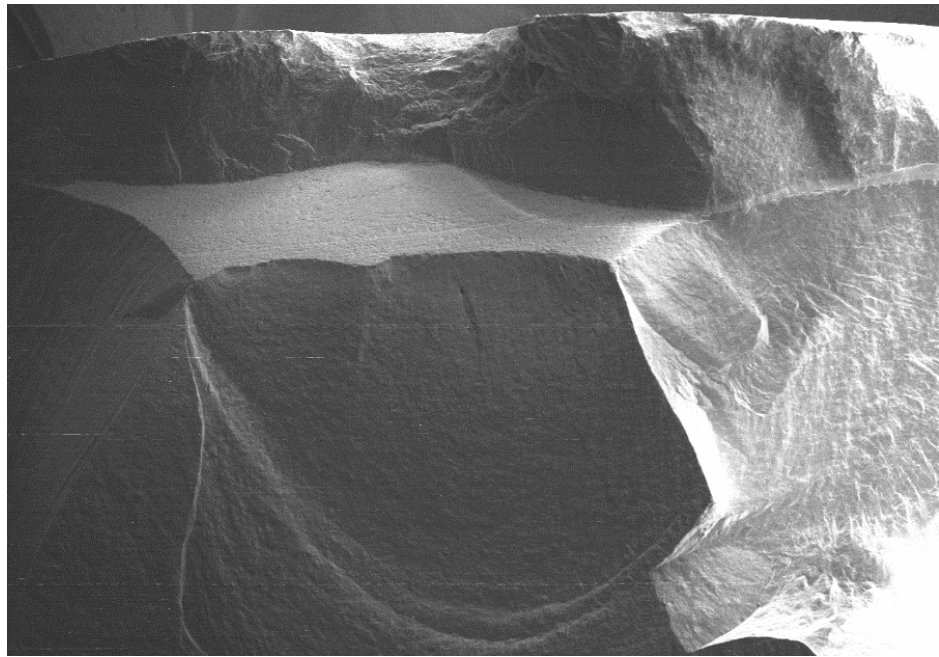
Figure 7. SEM micrograph of the fractured veneered-zirconia crown repaired with Vita Triluxe Forte at magnification of 22×. Dent. J. 2020 , 8 , x FOR PEER REVIEW